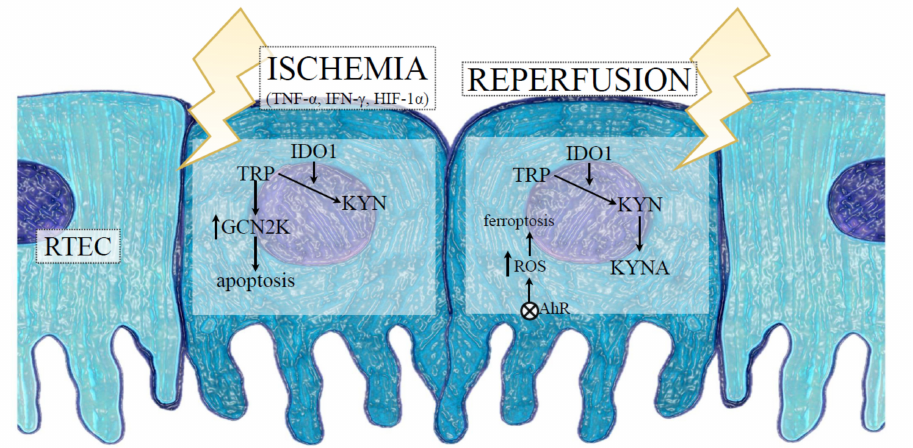
Figure 2. The role of indoleamine 2,3 dioxygenase 1 (IDO1) in RTEC death during IRI-induced AKI. The hypoxic conditions and proinflammatory cytokines released into the intrarenal environment, following the ischemic phase of IRI, induce IDO1 expression and KYN synthesis with simultaneous depletion of TRP in RTECs. The reduction of TRP in the microenvironment results in activation of GCN2K and apoptosis-mediated death of RTECs. After reoxygenation, IDO1-dependent activation of the kynurenine pathway in addition to the production of KYN and KYNA activates AhR, which triggers ROS generation, leading to AhR-mediated ferroptosis of RTECs. Abbreviations: RTECs— renal tubular epithelial cells; IRI—ischemia-reperfusion injury; TNF- α —tumour necrosis factor alpha; IFN- γ —interferon gamma; HIF-1 α —hypoxia-inducible factor-1alpha; TRP—tryptophan; KYN— kynurenine; KYNA—kynurenic acid; GCN2K—general control nonderepressible 2 kinase; ROS— reactive oxygen species; AhR—aryl hydrocarbon